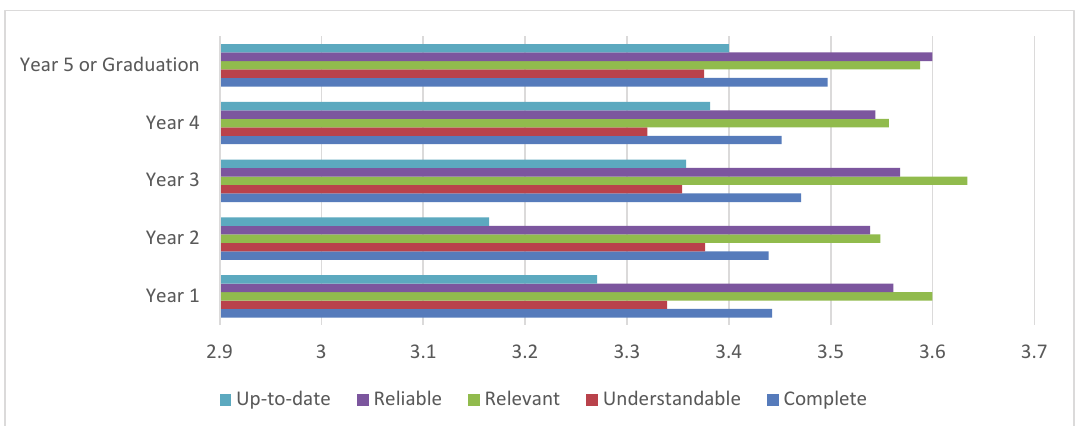
Fig. 2. Assessment of teaching methods among students in different school